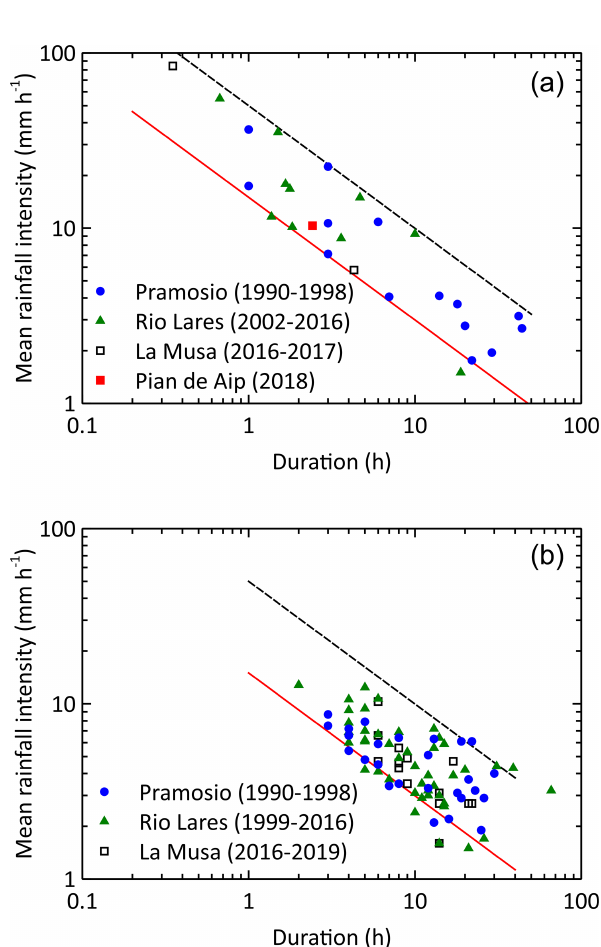
Figure 3. (a) Plot of mean rainfall intensity versus duration for debris-flow-triggering rainstorms; the rain gauge of Pian de Aip was used for the 2018 debris flow because of a gap in data in the La Musa rain gauge. (b) Plot of mean rainfall intensity versus duration for high-intensity rainstorms that did not trigger debris